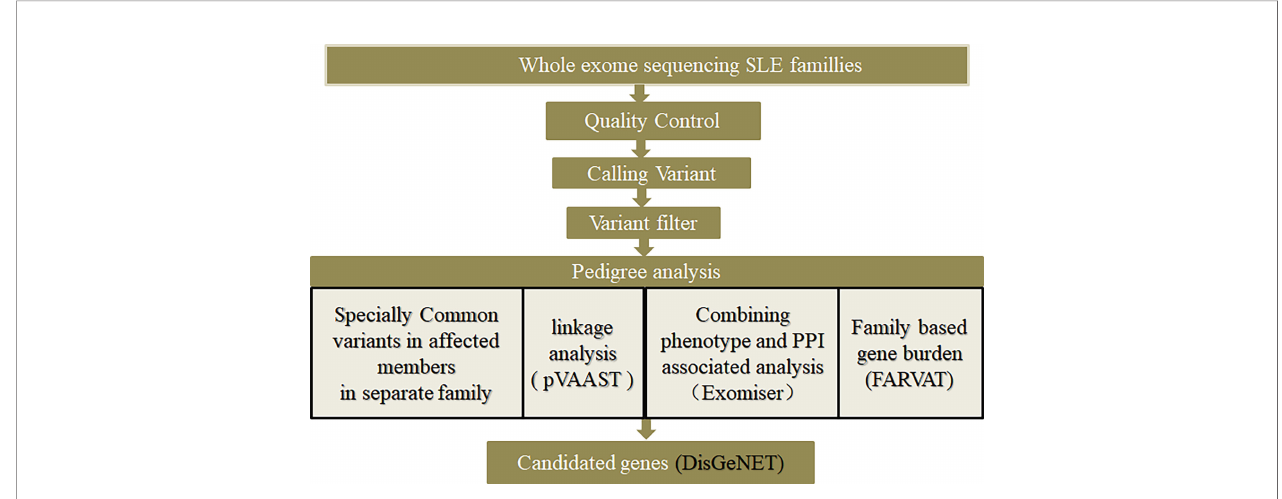
FIGURE 1 | Diagram of bioinformatic